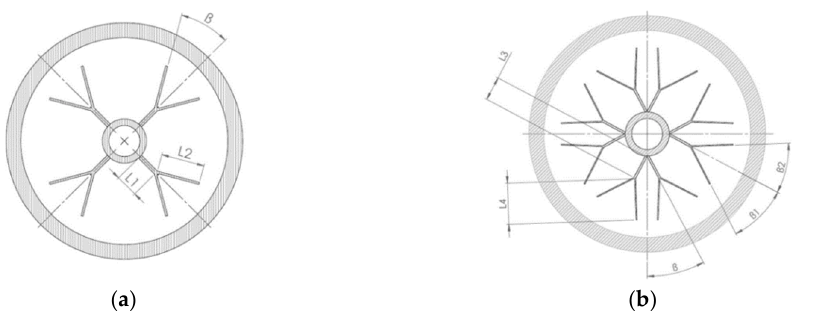
Figure 10. Different two-level dendritic fins [78]. ( a ) Single bifurcation; ( b ) Double bifurcation. (Permission to reproduce from Ref. [78]).